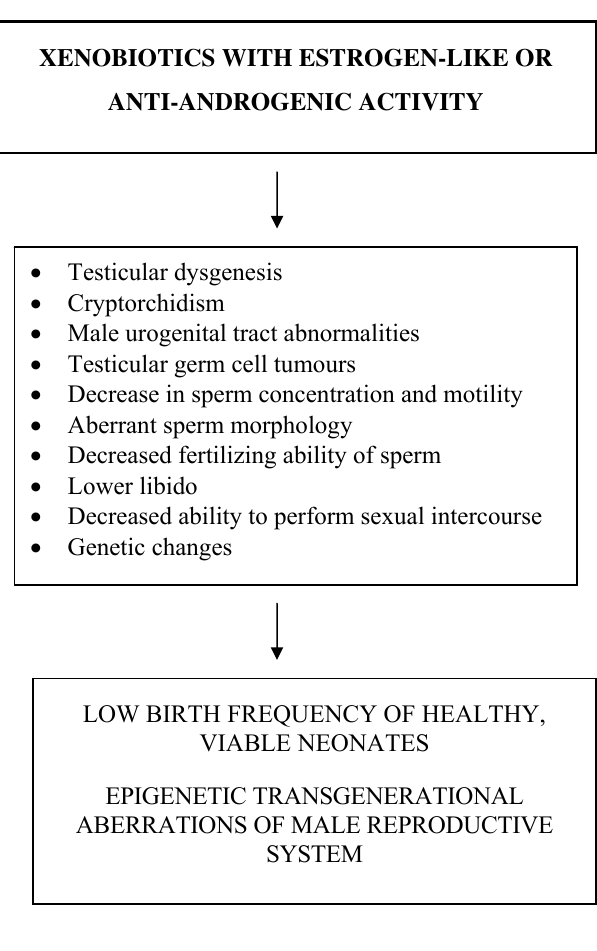
Fig. 1 Detrimental effects of xenobiotics with estrogen-like or anti-androgenic action in the